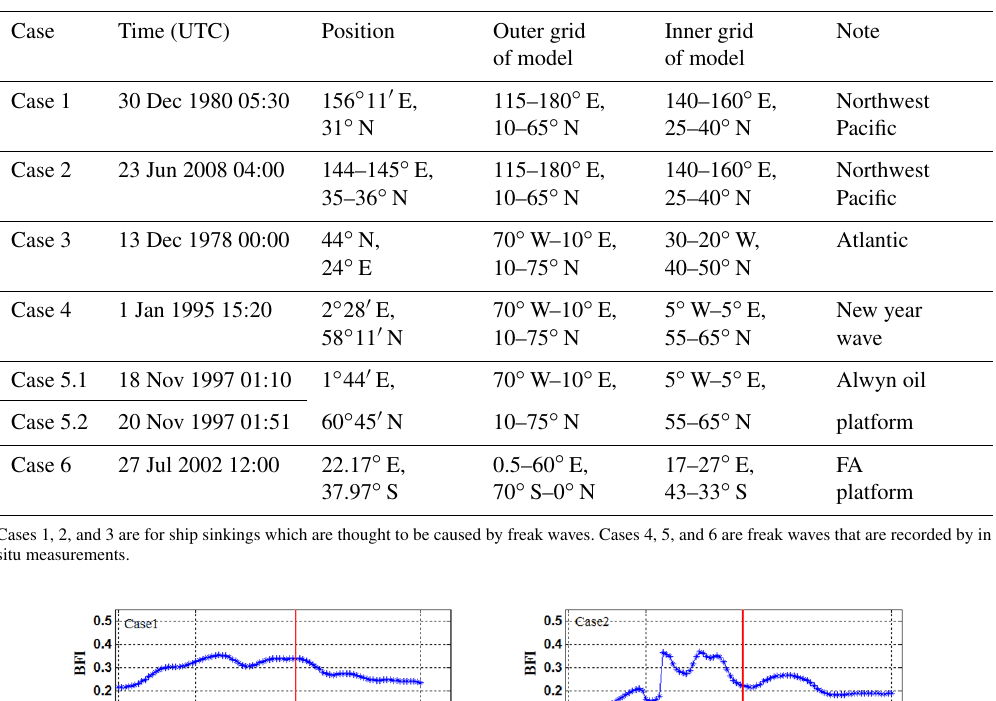
Table 1. Time, position information, and model setup of freak wave incidents.